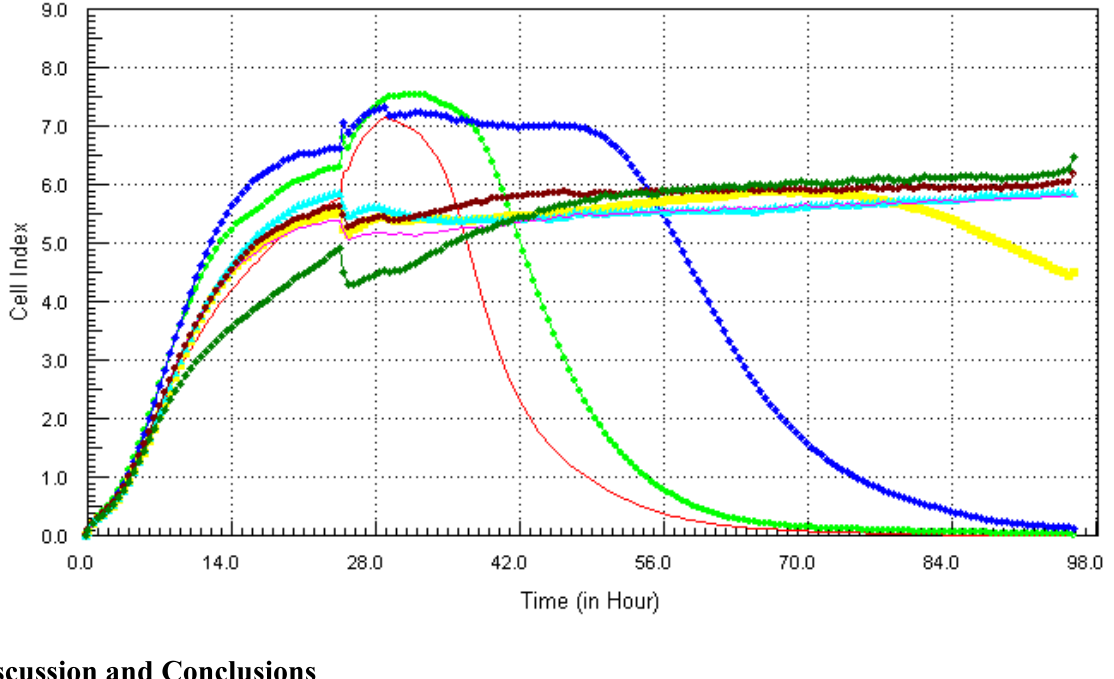
Figure 10. Kinetics of cytotoxicity responses for mixture in LBSO-treated MCF7 cells as described in Figure 6